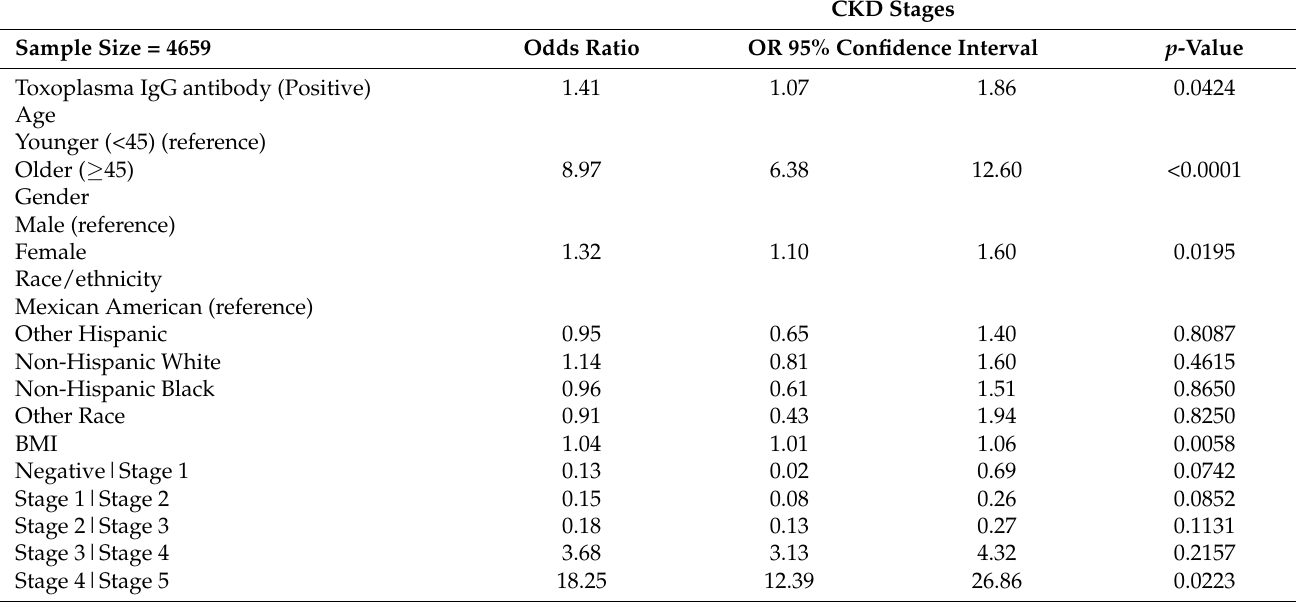
Table 9. Ordinal Logistic regression model for CKD stages on T. gondii IgG antibody (posi- tive/negative) adjusted for the demographic factors and BMI. CKD